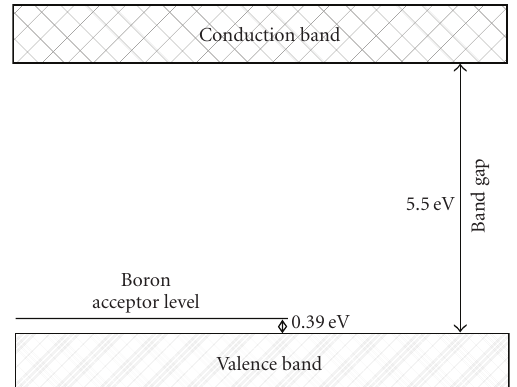
Figure 2: Boron acceptor level in the band gap of